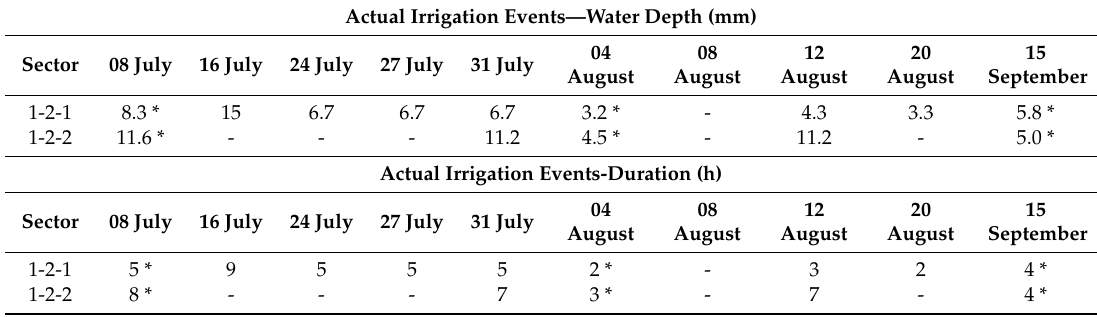
Figure 7. Soil water content measured by the WSN probes for Sector 1-2-2 in the period April–September 2018. The reported FC, WP and − 100 kPa, − 200 kPa, − 300 kPa thresholds refer to the 80 cm horizon only; irrigation, fertigation and rainfall events and are also reported. Table 5. Actual irrigation events (water depth and duration) for the two VRI sectors. Actual Irrigation Events—Water Depth